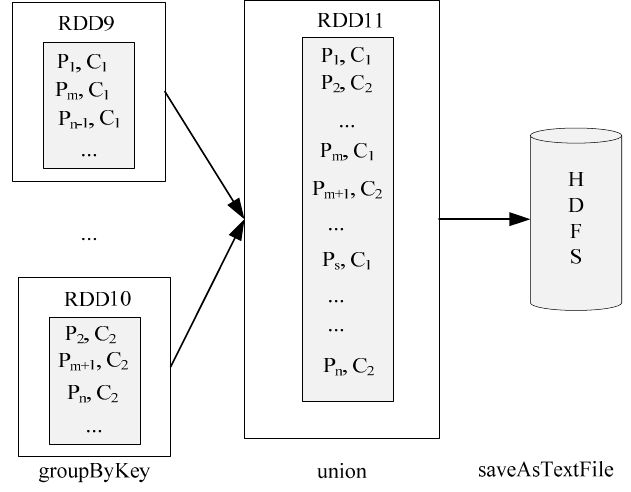
Figure 13. Flowchart of the RDD conversion of the global cluster generation.